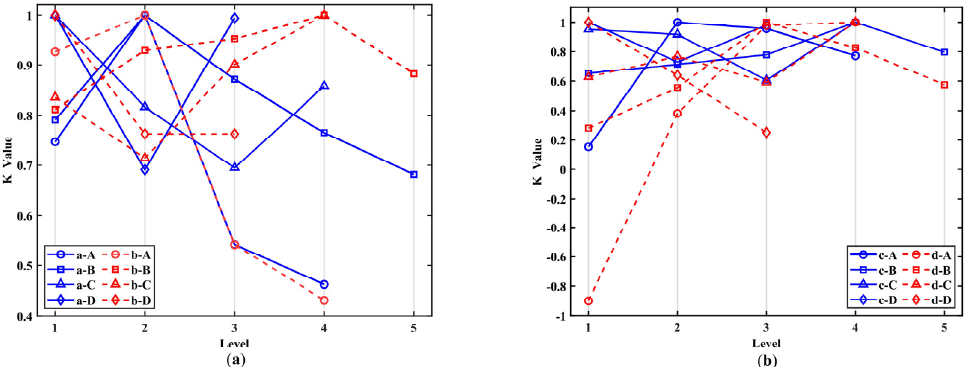
Figure 12. The rotor’s normalized K value curve. ( a ) Hover flight. ( b ) Forward flight.